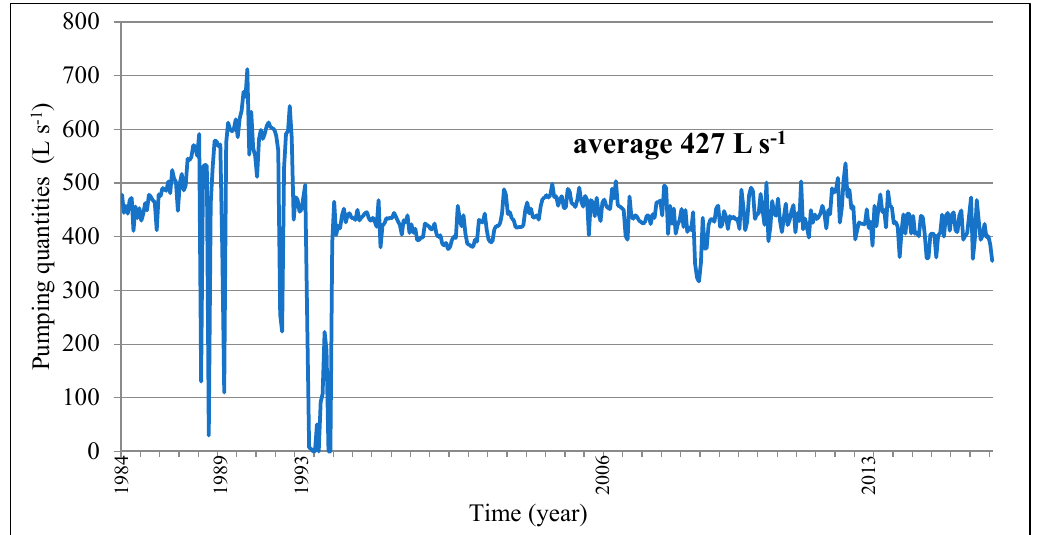
Figure 2. Profile of Quaternary deposits affected by wells of Vinogradi Pumping Station.